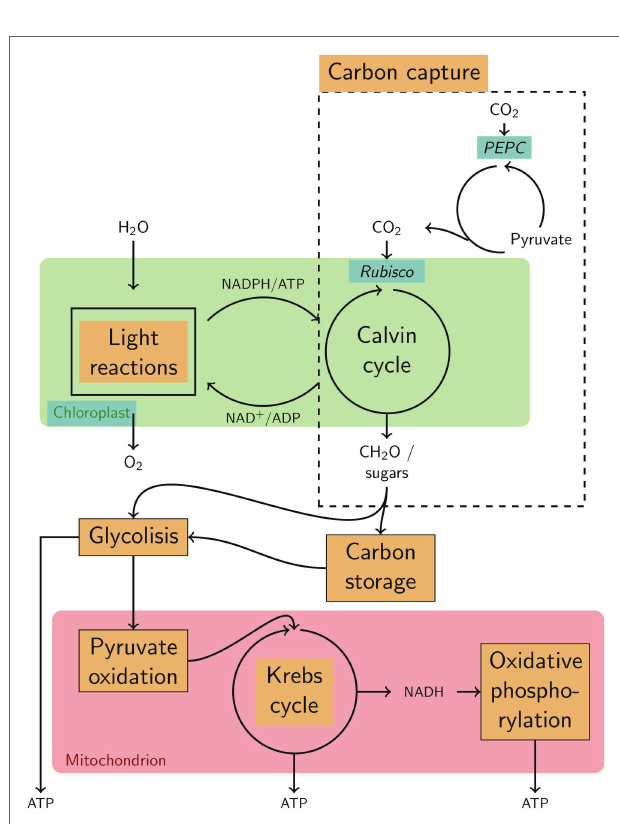
( Supplementary Figure 8 ), and were enriched for upregulated genes in the pentose phosphate pathway (ko00030; Supplementary Figure 9 ).